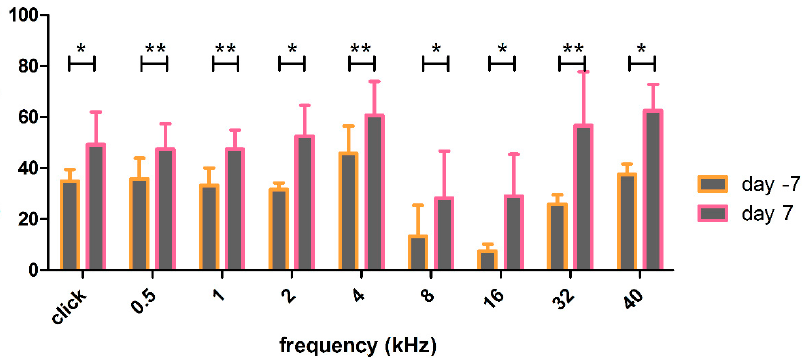
Figure 11. Effect of noise and implantation on hearing thresholds. The hearing thresholds of the implanted and noise traumatized ears show a significant, but frequency specific, increase over the whole time period. * p ≤ 0.05; ** p ≤ 0.01.